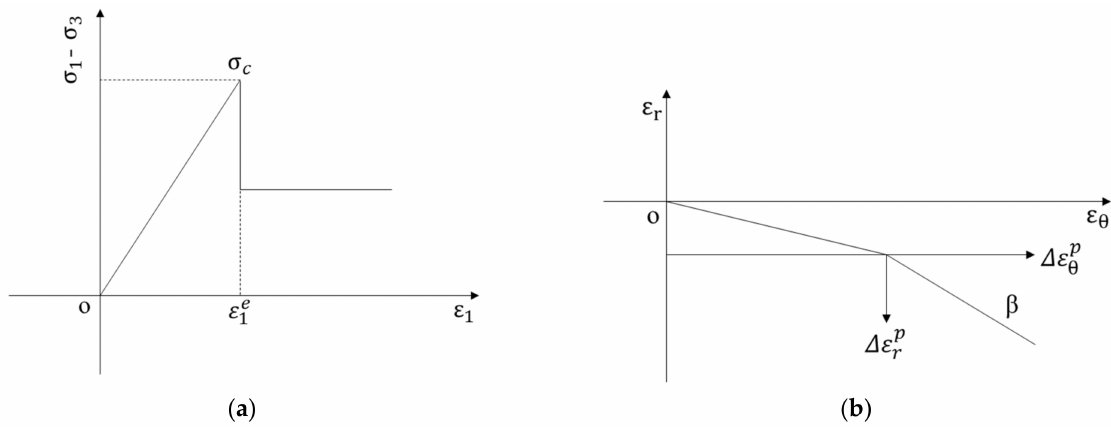
Figure 12. ( a ) Elastic–brittle–plastic constitutive curve. ( b ) ε r — ε θ strain